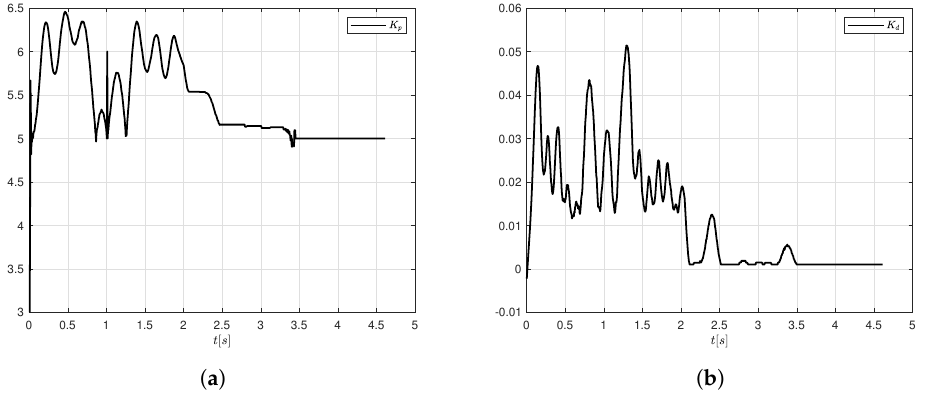
Figure 14. Real time response of the controller gains ( a ) Kp and ( b ) K d